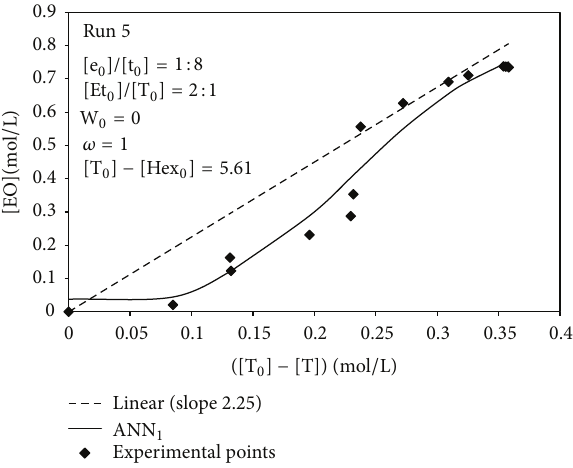
Figure 2: Comparison between experimental data, ANN 1 pre- diction and linear empirical correlation ([EO] = 2.25 ∗ ([T 0 ] − [T]) exploited in the previous paper [12], for the determination of the relationship between ethyl oleate production and triolein consump- tion. Operating conditions: run 4 of Table 1.